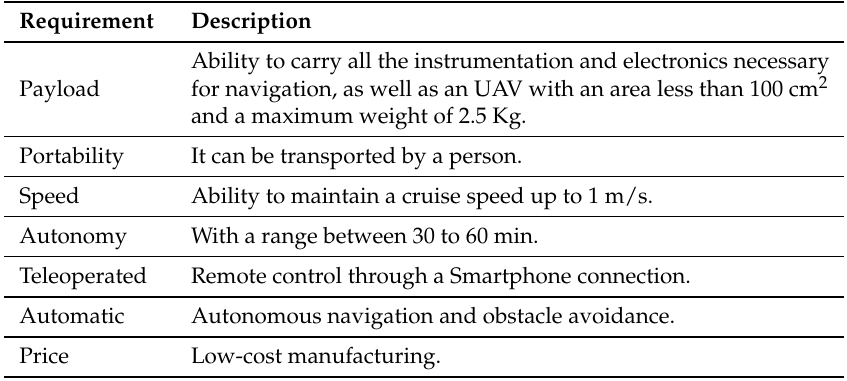
Table 1. System design requirements.